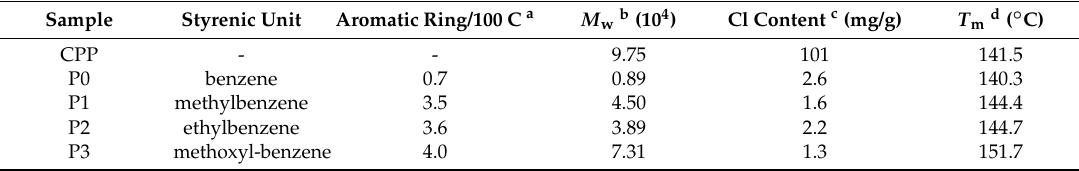
Figure 1. 1 H-NMR spectrum of chlorinated polypropylene. Table 1. Synthesis of the propylene- co -styrenic monomer copolymers. CPP, chlorinated